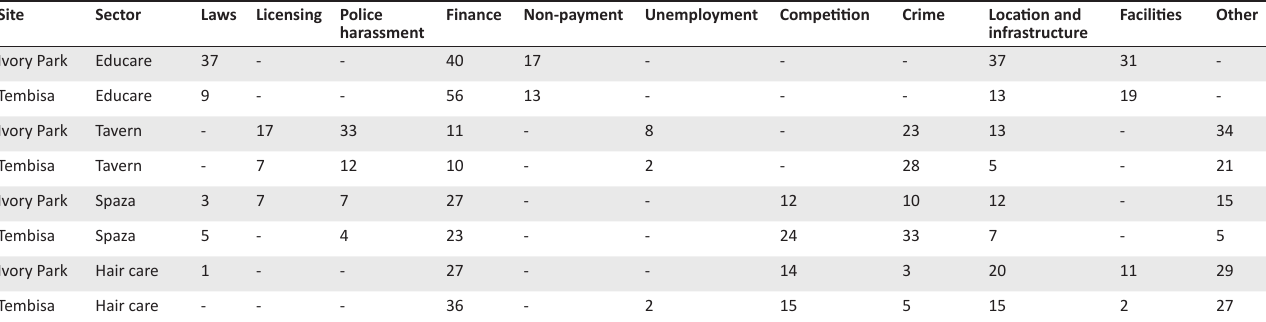
TABLE 7: Perceived obstacles to enterprise growth ( % responses and/or categories). Site